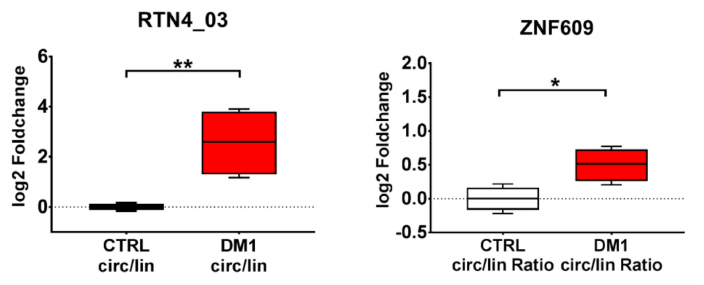
Figure 5. Di ff erentially modulated circular-to-linear ratios in myogenic cell lines. Boxplots of significantly di ff erent circular-to-linear ratios identified by qPCR in di ff erentiated DM1 myogenic cells compared to controls (* p < 0.05; ** p < 0.01; DM1 = 4; CTRL =